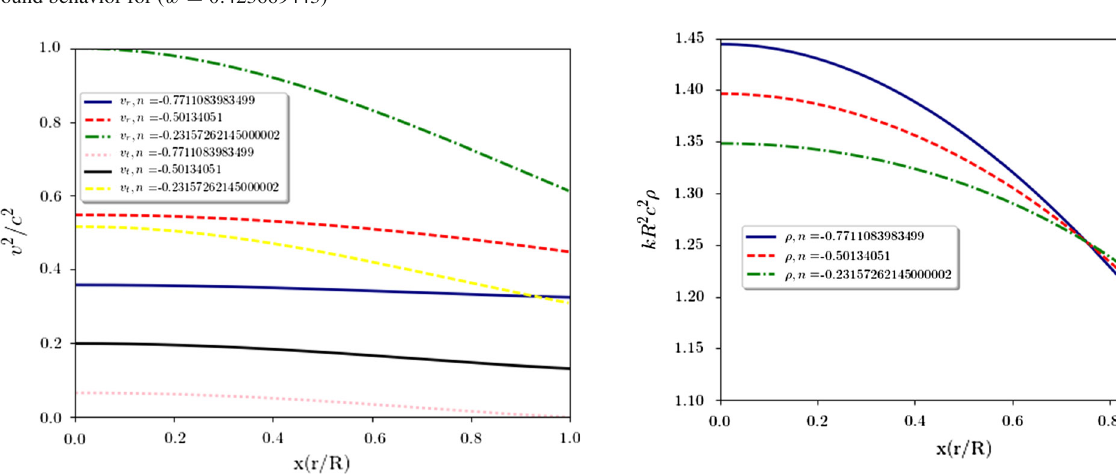
Fig. 3 Graphical representation of radial and tangential pressure behavior